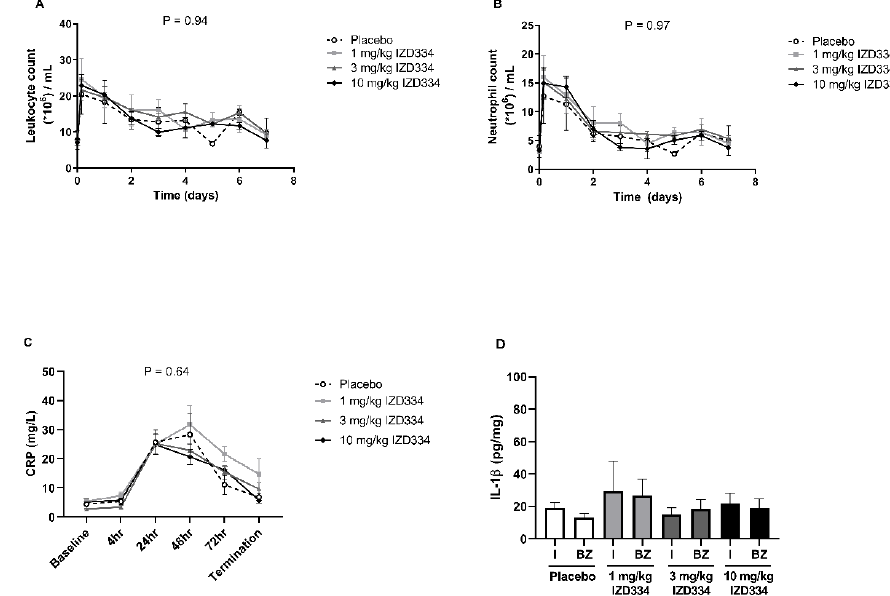
Figure 4. Serological and histological inflammatory read-outs. ( A ) Circulating levels of leukocytes and ( B ) neutrophils during the 7-day follow-up period. ( C ) Circulating levels of C-reactive protein (CRP) during the 7-day follow-up. ( D ) Myocardial interleukin (IL)-1 β levels, measured in infarct (I) and border zone (BZ) regions of the pig heart. Data are presented as mean ± SEM ( p -values following mixed models testing). N.B. The first three timepoints of the analysis are baseline, 4 h after reperfusion, and 24